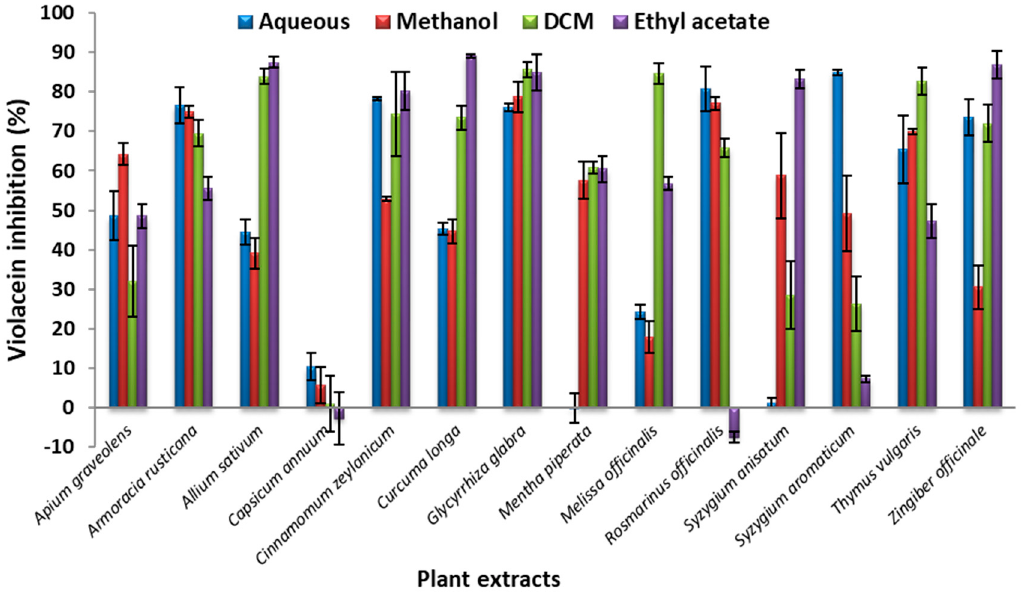
Figure 1. Percentage inhibition of violacein production after exposure of Chromobacterium violaceum to solvent extracts (0.7 mg/mL) of herbs and spice. Data presented as mean ± standard deviation (SD). Further percentage violacein inhibition results for plant extracts over a range of concentrations are provided as supplementary data (Table S1).